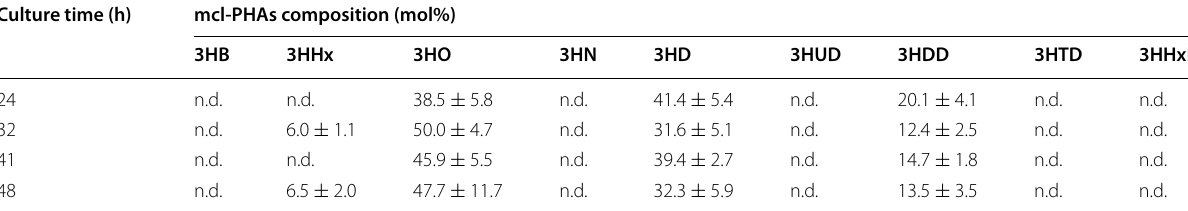
3HB 3‑hydroxybutyrate, 3HHx 3‑hydroxyhexanoate, 3HO 3‑hydroxyoctanoate, 3HN 3‑hydroxynonanoate, 3HD 3‑hydroxydecanoate, 3HUD 3‑hydroxyundecanoate, 3HDD 3‑hydroxydodecanoate, 3HTD 3‑hydroxytetradecanoate, 3HHxD 3‑hydroxyhexadecanoate, n.d. not detected